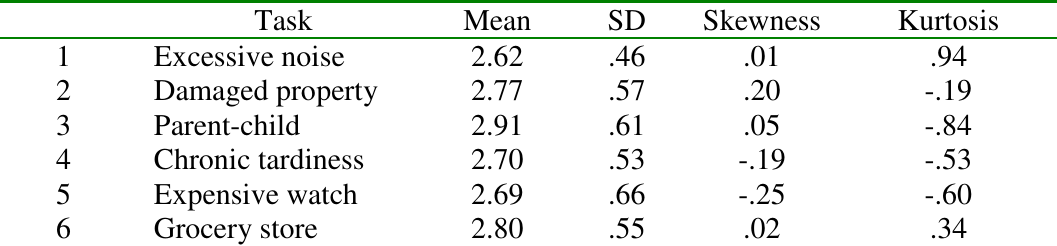
Descriptive Statistics for the Six Tasks (N = 90)